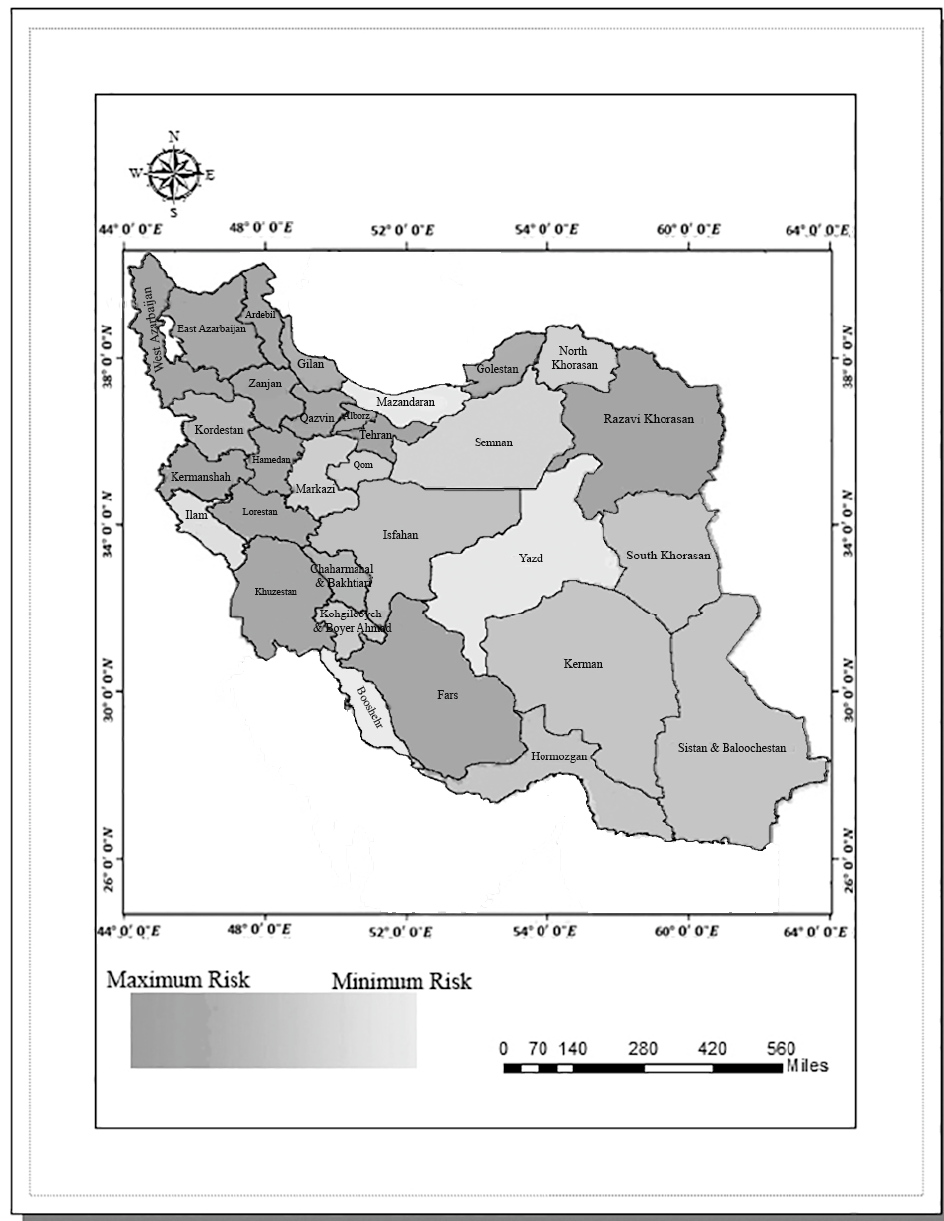
Figure 14. Iran drought risk map at a provincial level (2016).